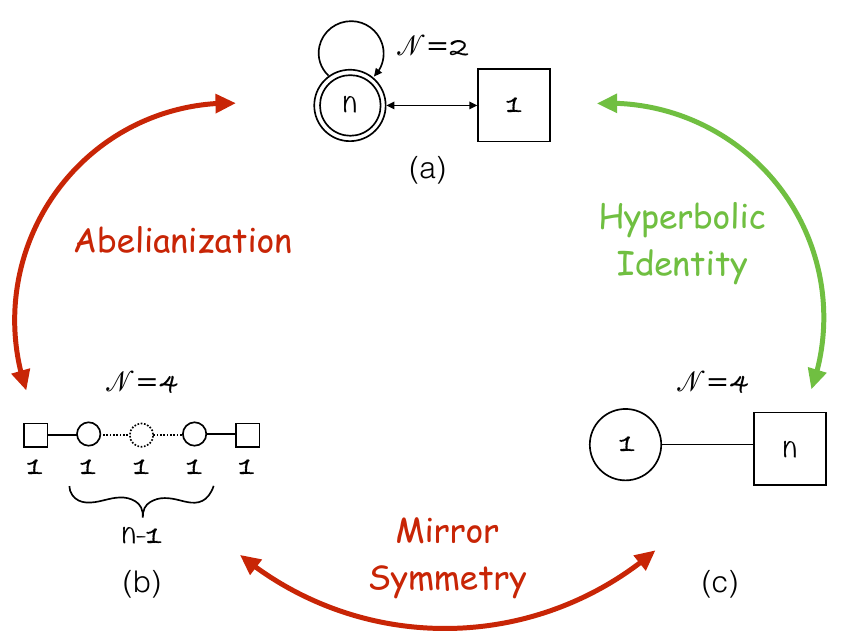
Figure 1 . Relation between the relevant models describing the 3d ( A 1 ; A 2 n (cid:0) 1 ) AD theories reduced to 3d. We also specify the degree of supersymmetry of the quivers under consideration. The double circle denotes an SU( n ) gauge theory while single circles refer to unitary cases with abelian factors. Flavor symmetries are denoted by